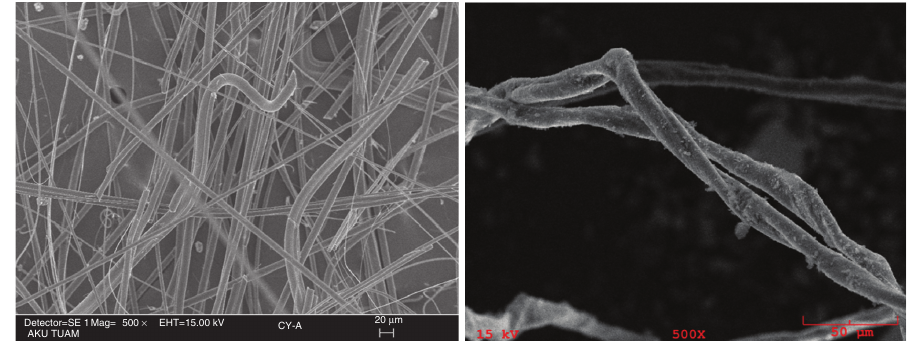
Figure 2 SEM image (500 × ) of glass fiber (left) and organic fiber (right).